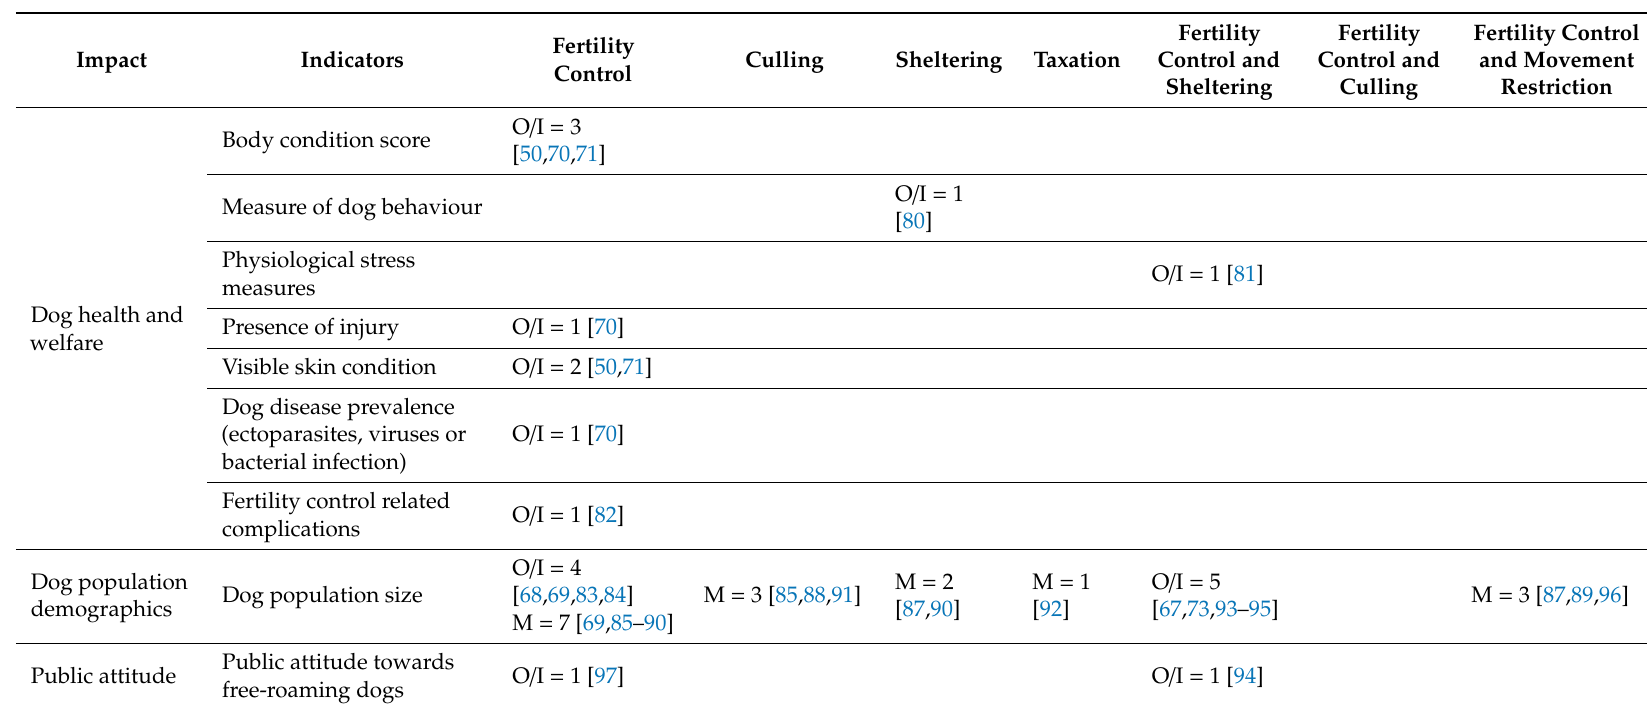
Table 1. Impact categories and indicators of e ff ect used in the final corpus to evaluate the e ff ects of management methods. Study design is indicated with either O / I indicating an observational or intervention study, or M for a modelling study. Following the indication of study design is the number of papers (denoted = n , where n is the number of papers) adopting this design to test this combination of dog population management method, indicator, and measured impact, followed by the reference details for the relevant